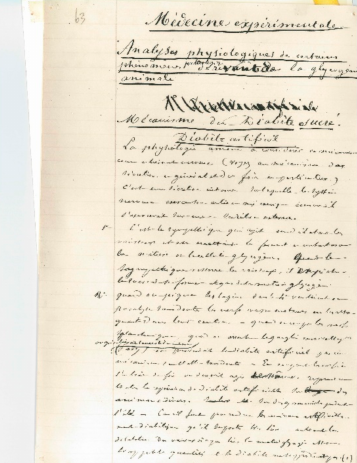
Figure 4. Claude Bernard’s manuscript of a lesson in experimental medicine. Mus é e Claude